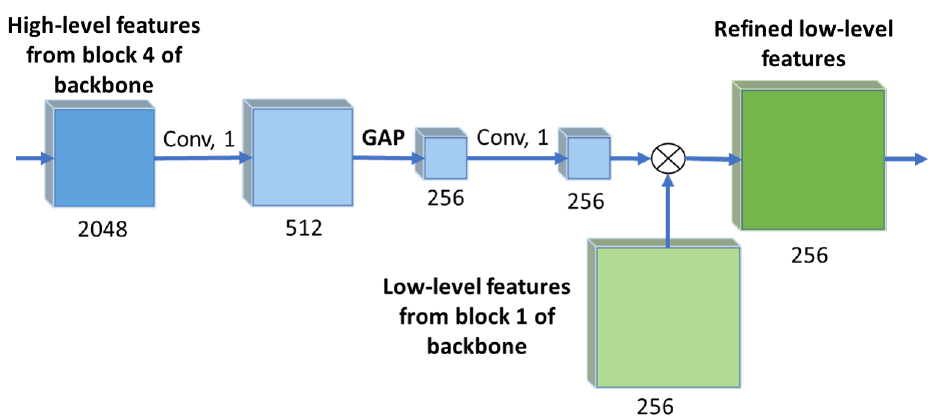
Figure 3. Channel attention module architecture. The high-level features from the backbone are fed to a 1 × 1 convolution to reduce the number of maps to 512, followed by a global average pooling layer (GAP) and another 1 × 1 convolution, generating 256 maps. These maps are then multiplied with the low-level features from the backbone, generating the refined low-level features. The numbers below each block indicate the number of feature